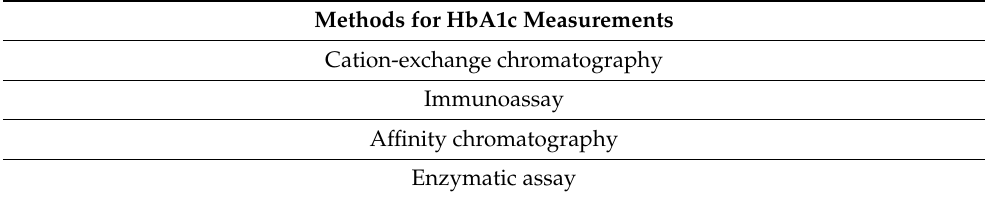
Table 1. List of the most common scientifically supported methods for HbA1c